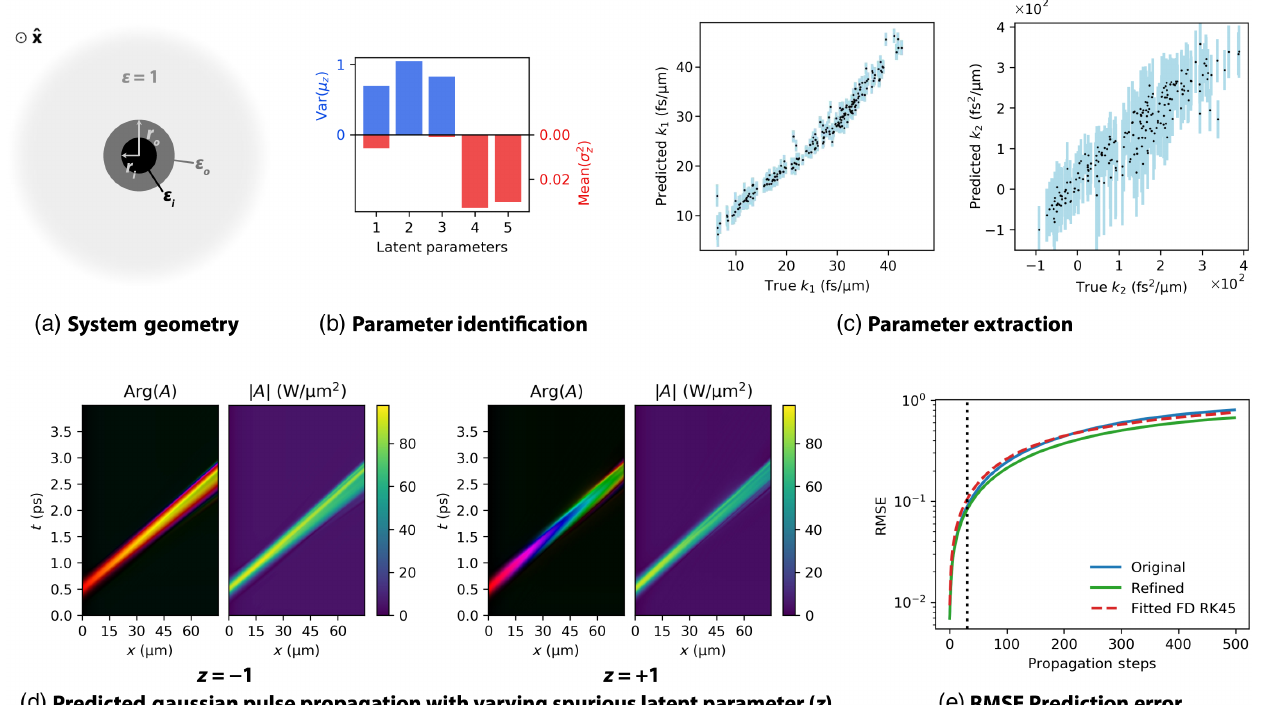
FIG. 6. Analysis of the model trained on the nonlinear fiber propagation dataset. (a) The cross section of the fiber shows the cladding with (relative) permittivity ε ¼ 1 , the inner core with radius r and permittivity ε , and the outer core with radius r and permittivity ε . i i o o (b) Three relevant latent parameters are identified by the trained model. (c) A linear fit of the latent parameters predicts the true k 1 with R 2 ¼ 0 . 966 and k 2 with R 2 ¼ 0 . 863 , corresponding to group velocity and second-order dispersion. (d) Varying the remaining spurious latent parameter z while propagating a Gaussian pulse using the trained propagating decoder, we observe that the spurious parameter represents a phase velocity. The plot of Arg ð A Þ shows the phase of the pulse mapped to the color hue while the amplitude is mapped to lightness. (e) The root mean squared prediction error at each propagation step of the originally trained PD (blue) and a further refined PD (green) are comparable to an explicit solution (second-order finite difference, adaptive fourth-order Runge-Kutta method) of the effective equation (13) with fitted parameters (up to fourth-order dispersion) for each individual test set example (dashed